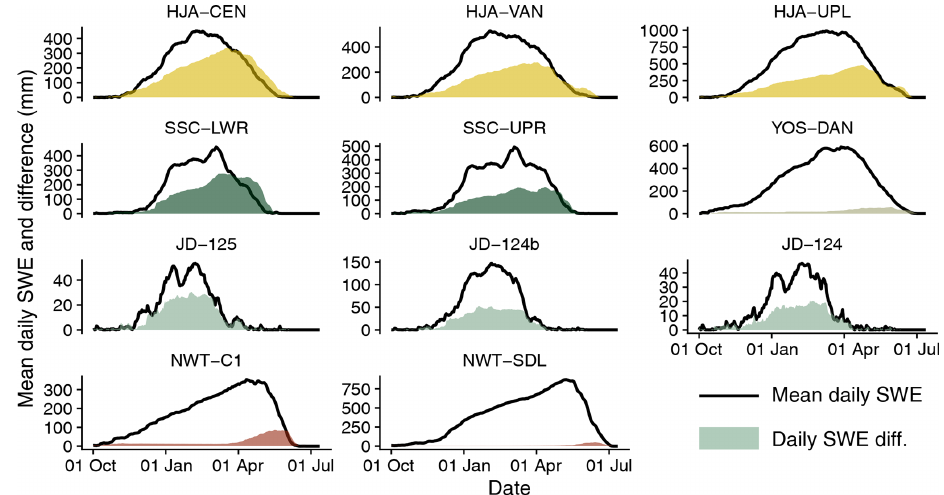
Figure 6. Mean daily simulated SWE (solid black line) and the difference between maximum and minimum mean daily SWE (shading) at the study stations. The mean daily SWE was computed by averaging the simulated SWE on each day for all precipitation phase methods across the simulation years. The difference was calculated by subtracting the minimum mean daily SWE from the maximum mean daily SWE produced by the different precipitation phase methods (mean daily SWE plots broken out by precipitation phase method can be viewed in Figs. S1–S11). The T a0 and T ar0 methods typically produced the minimum mean daily SWE, while T a3 and T d1 produced the maximum.